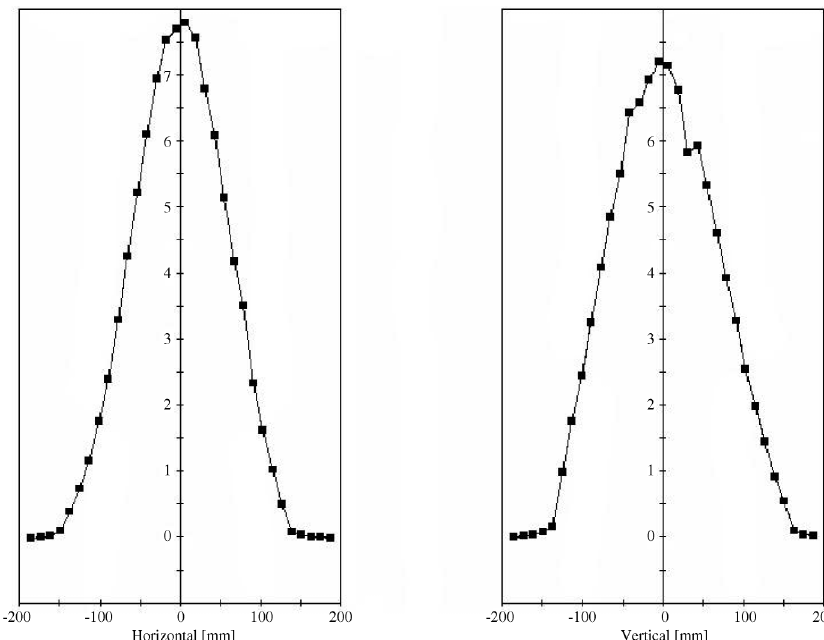
FIG. 5. The horizontal and vertical projections of the beam’s distribution at the target location of the NSRL beam-transport line when the octupoles shown in Figs. 2 and 3 are OFF. These beam profiles correspond to the line’s first-order beam optics which satisfies the beam constraints discussed in the Sec. III